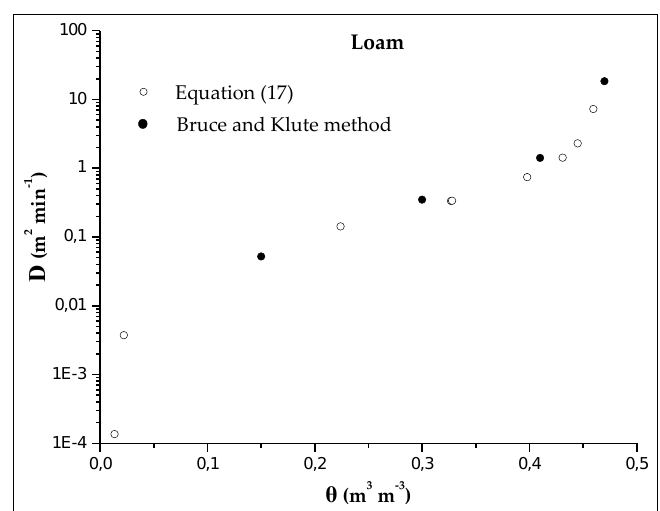
Figure 3. A comparative presentation of the relationship D ( θ ) as obtained according to the Bruce and Klute [14] method (Equation (16)) and Equation (17) for the loamy (L) soil. In Figure 4, the F (Θ) relationship for the linear Equation (13) and the Green–Ampt soils (Equation (11)) is shown, together with that obtained according to Equation (15) for all soils examined. The experimental F (Θ) points for all soils were obtained by the application of Equation (10) and the measured value of the sorptivity S (Equation (18)). From the results, it is shown that the one-parameter Equation (15) gave practically the same values for the F (Θ) relationships as the ones obtained experimentally, and lies between the two limits (linear and Green–Ampt soils) in all cases that were examined.